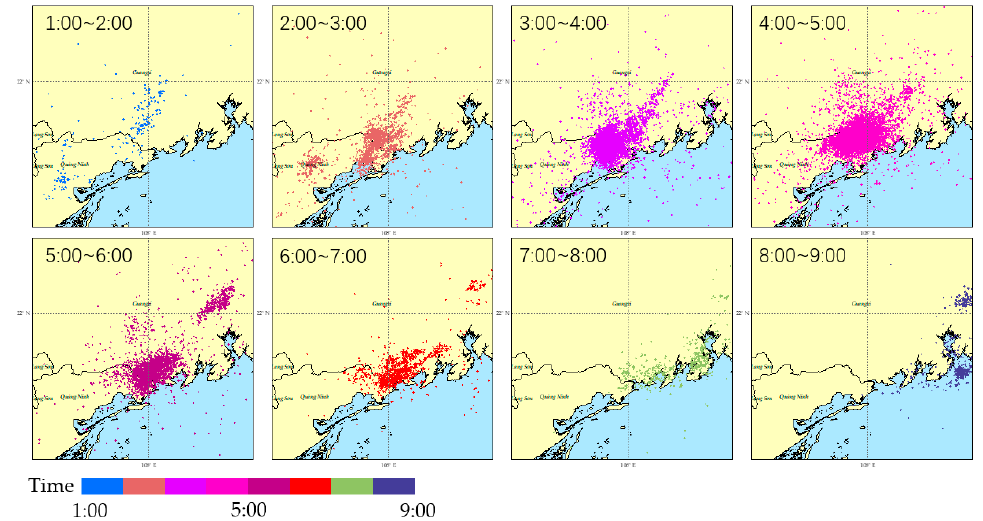
Figure 11. A thunderstorm took place between 1:00 and 9:00 am on 26 May 2019, Beijing time. Different colors represent different time periods and each scattered dot represents a lightning. The range of thunderstorms is in the coastal areas of southwestern Guangxi, China.